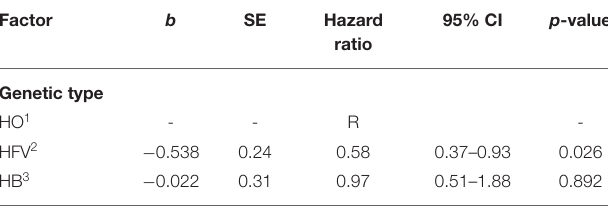
TABLE 6 | Hazard ratio for the culling rate in primiparous purebred Holsteins and their crossbred cows (time variable was the age at